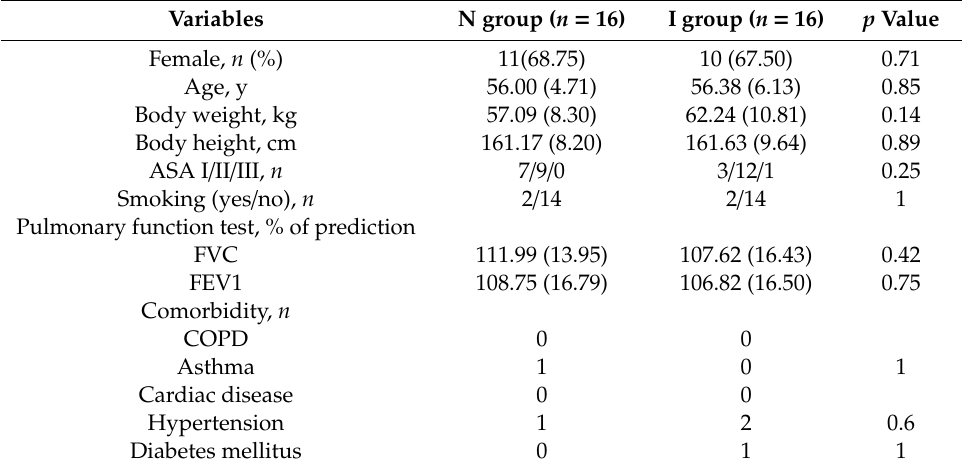
Table 1. Characteristics of patients in N and I groups.